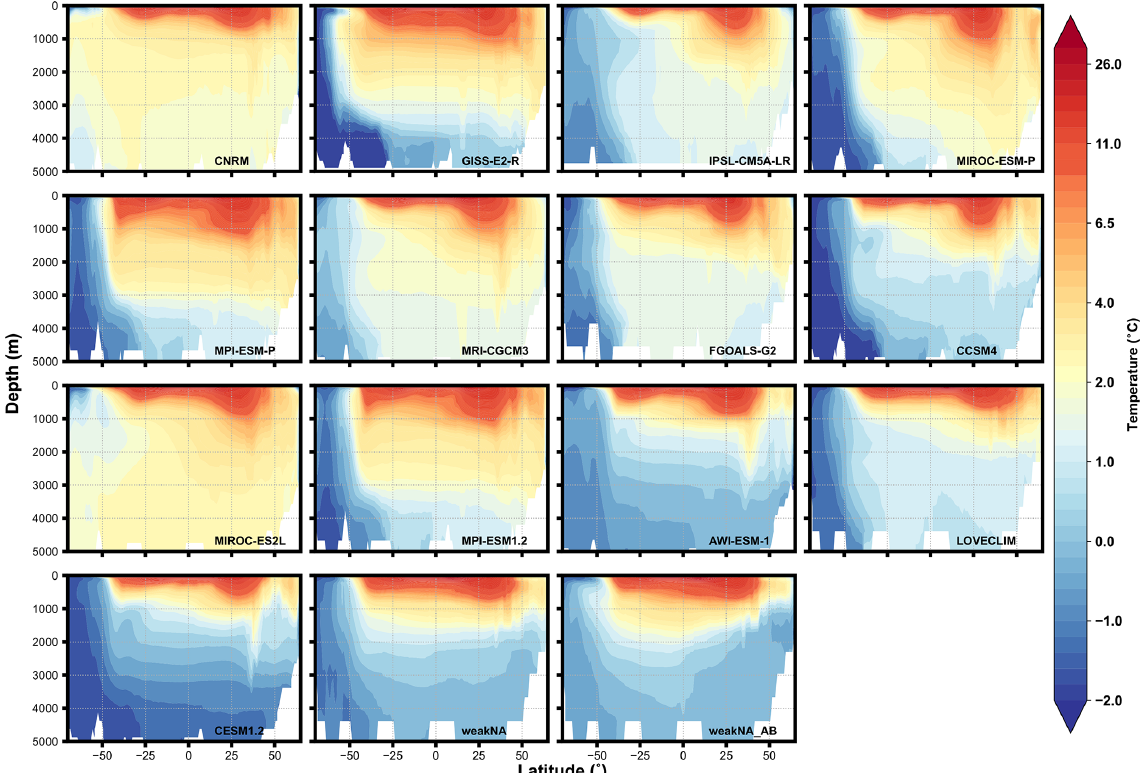
Figure 6. Zonally averaged oceanic potential temperatures ( ◦ C) in the Atlantic basin for PMIP3, PMIP4 and LOVECLIM simulations.